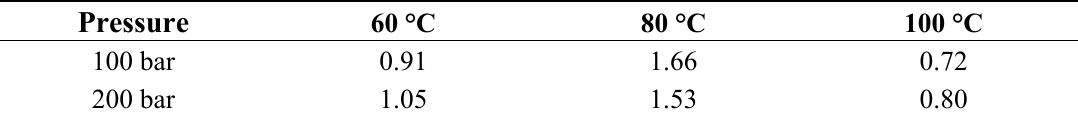
Table 3. Antioxidant activity expressed as AAI of extracts obtained by PLE under different extraction